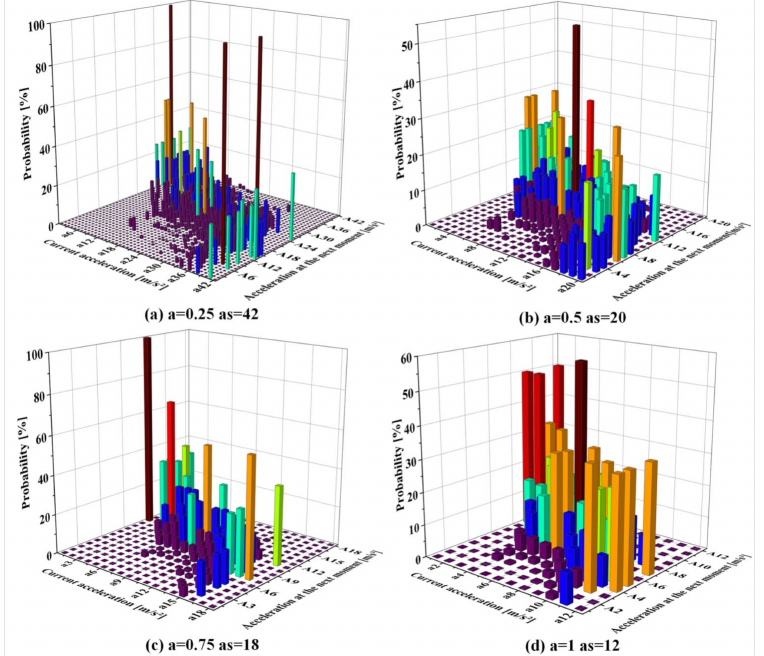
Figure 15. State transition probability matrix generated in different